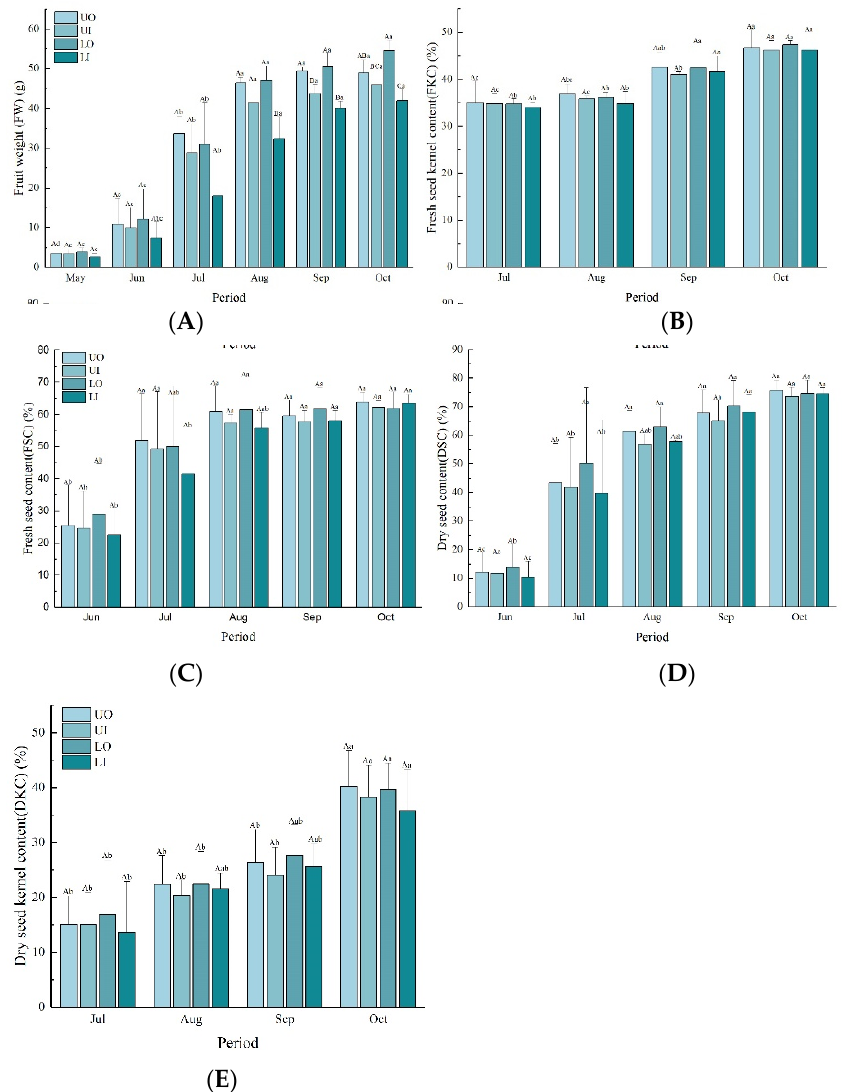
Figure 2. ( A ) Fruit weight, ( B ) fresh seed kernel content, ( C ) fresh seed content, ( D ) dry seed content, ( E ) dry seed kernel content of C. oleifera ‘Huaxin’ at different positions of the canopy. Data are represented as mean values ± standard deviation (SD; n = 6). Different uppercase and lowercase letters indicate significant differences ( p ≤ 0.05; Duncan’s multiple range tests) between locations and periods, respectively.